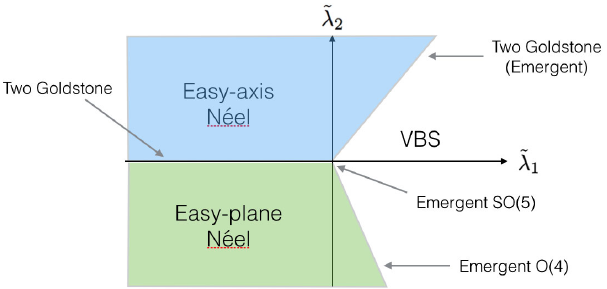
FIG. 3. Phase diagram near the SO(5)-invariant fixed point with ~ λ 2 þ j z 2 Þ þ ~ λ 2 − j z 2 Þ 2 − perturbation of the form − 1 ðj z 1 j 2 j 2 ½ðj z 1 j 2 j 1 z 1 j 2 þ j z 2 j 2 Þ 2 (cid:4) . This is the natural perturbation to consider in 3 ðj the context of deconfined criticality in quantum magnets. The emergent SO(5) symmetry requires that the slope of the lower transition line is twice that of the upper transition